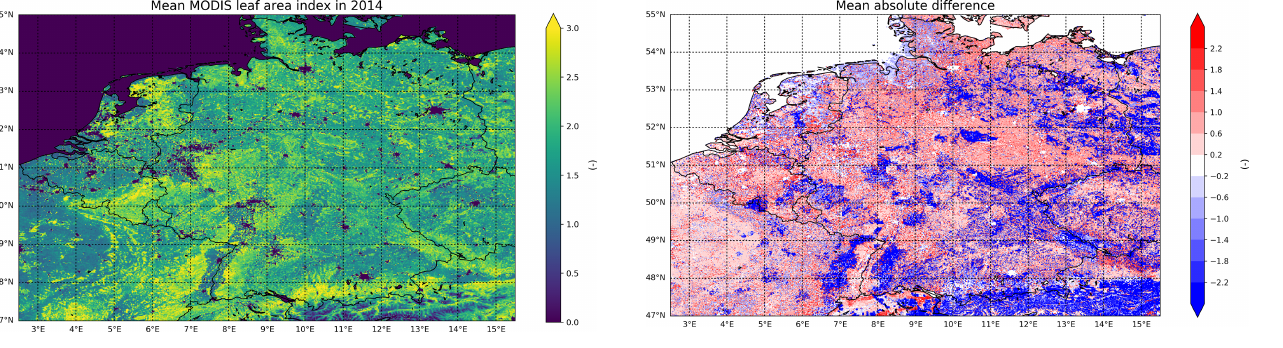
Figure 6. The yearly mean MODIS leaf area index in 2014. Figure 7. The absolute differences (LAI MODIS – LAI default ) be- tween the MODIS leaf area index and the default leaf area index in